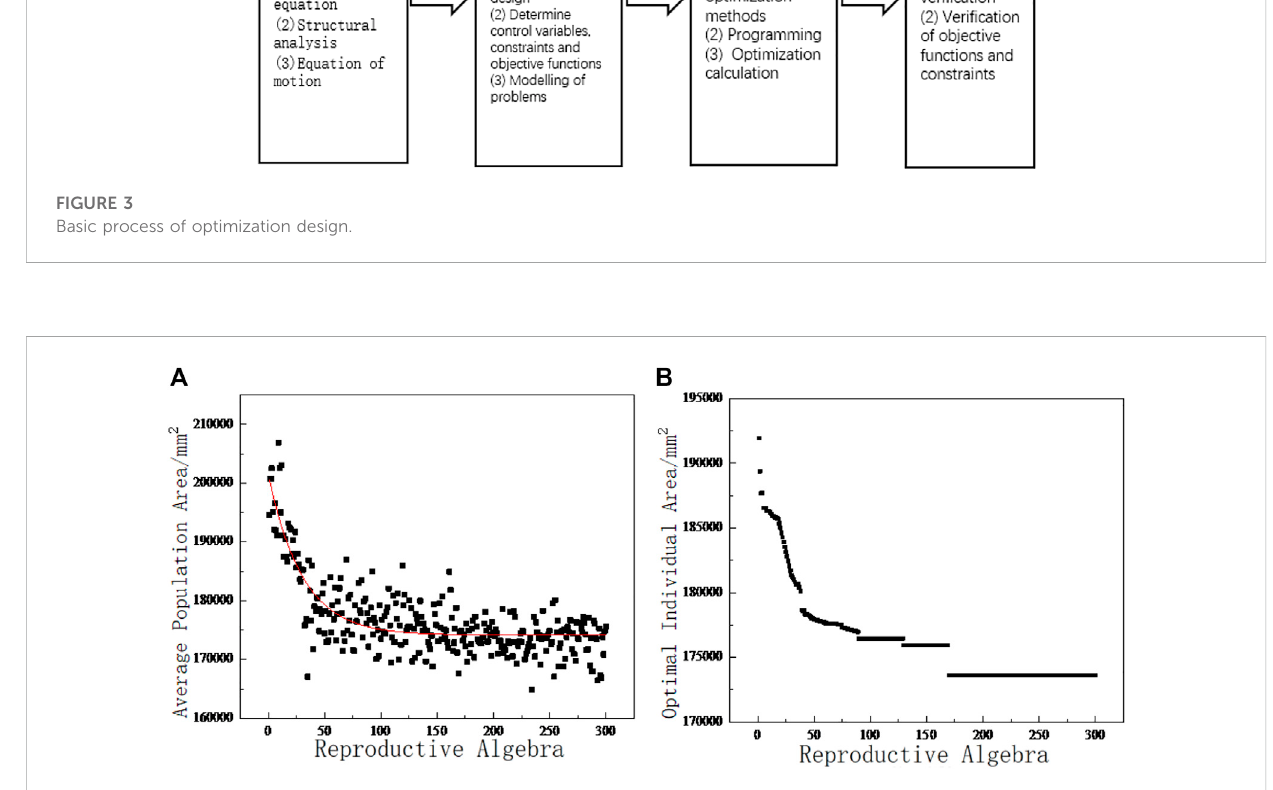
FIGURE 4 Iteration process. (A) Average area and (B) optimal individual area.